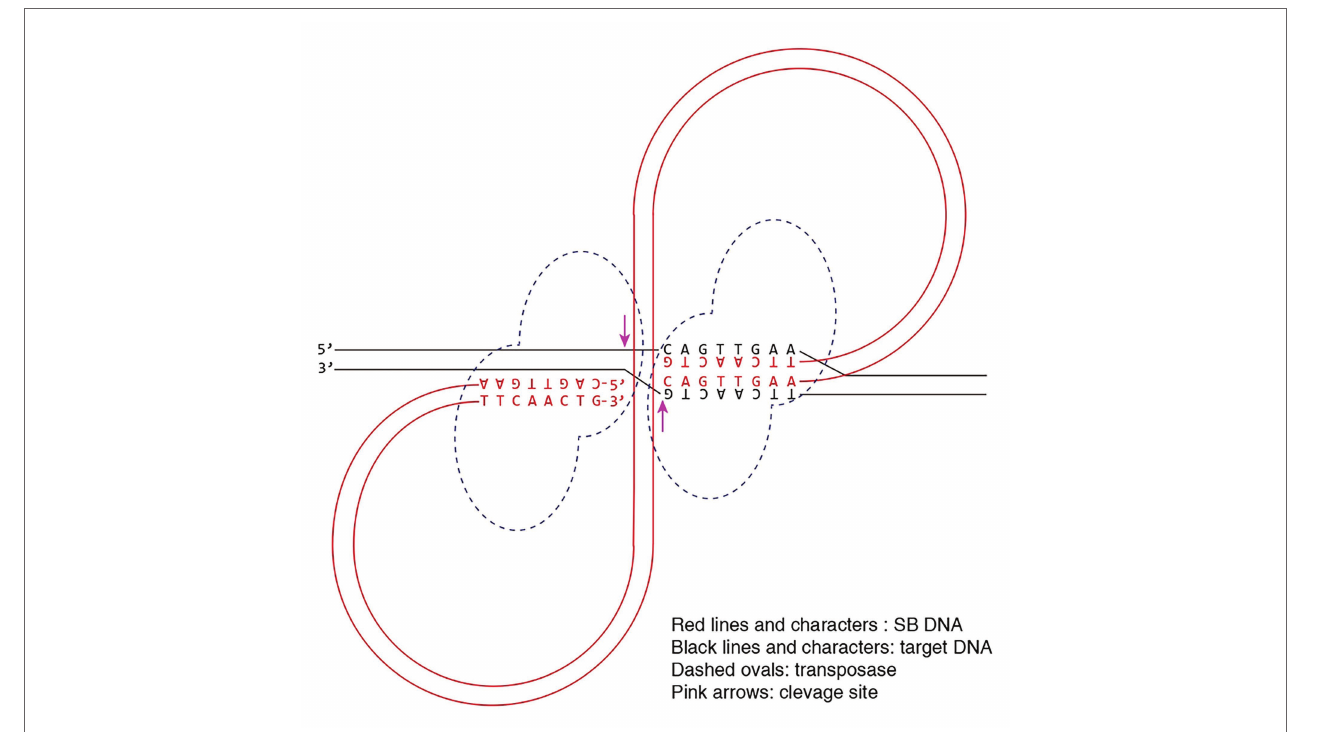
FIGURE 5 | Model for the alternative integration mechanism of Sleeping Beauty transposon. The pre-integration complex (PIC) recognizes the target site via the interaction between the transposon DNA and the target